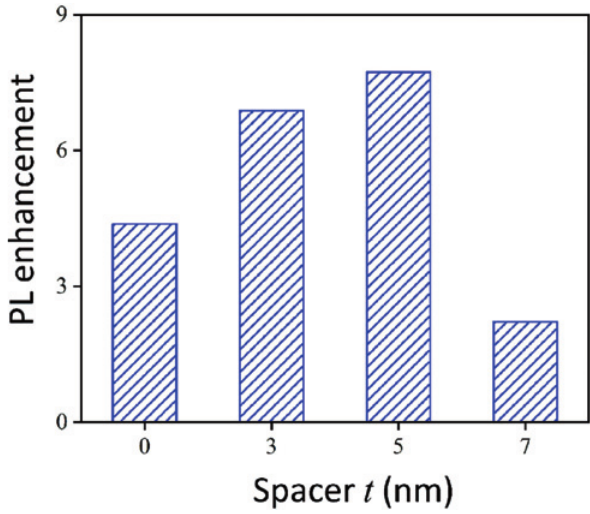
Figure 3: PL enhancement factors for the spectra at the A1 bands using different spacer thicknesses. The thickness of the Al 2 O 3 spacer was 0, 3, 5, and 7